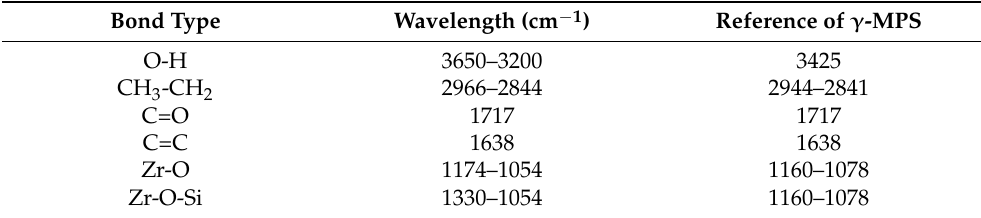
Table 2. Bond type and wavelength of Silane coupling agent, 3-trimethoxysilyl propyl methacrylate ( γ -MPS) and silanised zirconia nanoparticles.